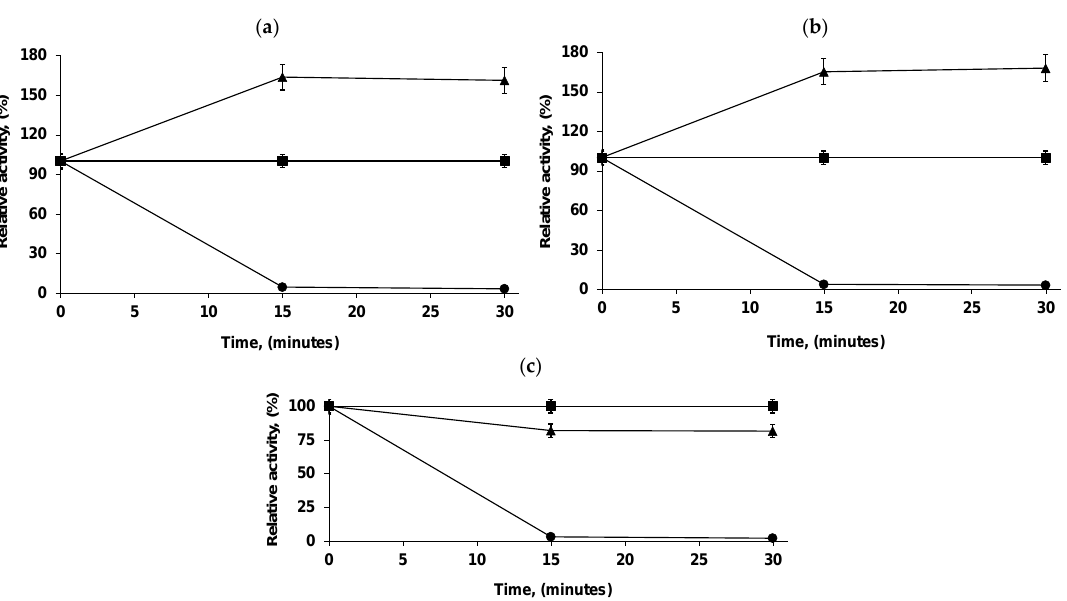
Figure 3. Immobilization courses of ET on octyl agarose beads using different enzyme loadings: ( a ) 0.12 mg / g, ( b ) 0.2 mg / g, and ( c ) 1 mg / g. Other specifications are described in the Methods section. Filled squares: reference; filled triangles: suspension; filled circles: supernatant.